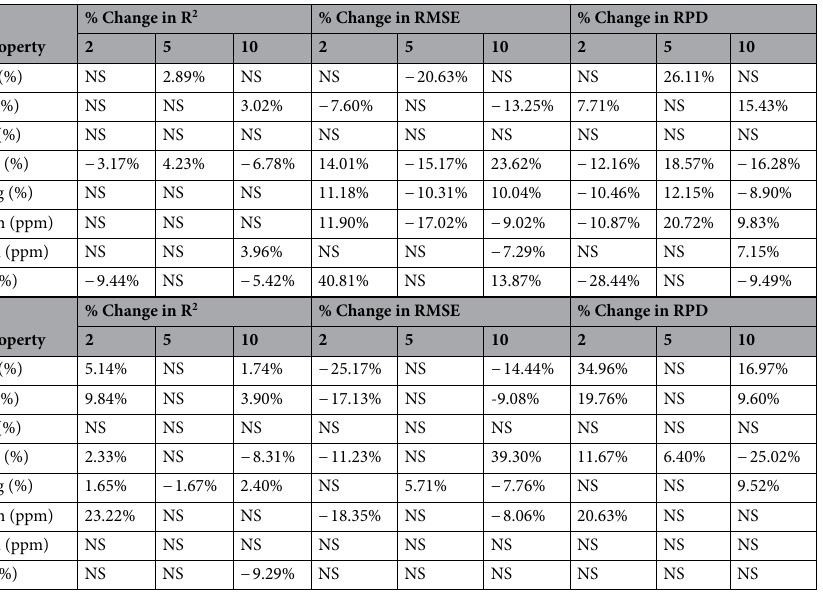
Table 1. Average percent change in R 2 , root mean square error (RMSE) and the ratio of performance to deviation (RPD) for 8 measured chemical properties for ATR (top) and DRIFT (bottom) techniques between different levels of fine grinding. A positive change in R 2 or RPD corresponds to an improvement in model accuracy, while a negative change is desirable for RMSE. Columns 2, 5, and 10 refer to fine grinding levels in minutes. For example, a value in column ‘2’ refers to the percent change between no fine grinding and two minutes of fine grinding. A negative value means the statistic value decreased from the previous grinding level. A value of ‘NS’ means that the percent change between fine grinding groups was not statistically significant at p < 0.05 compared to no fine